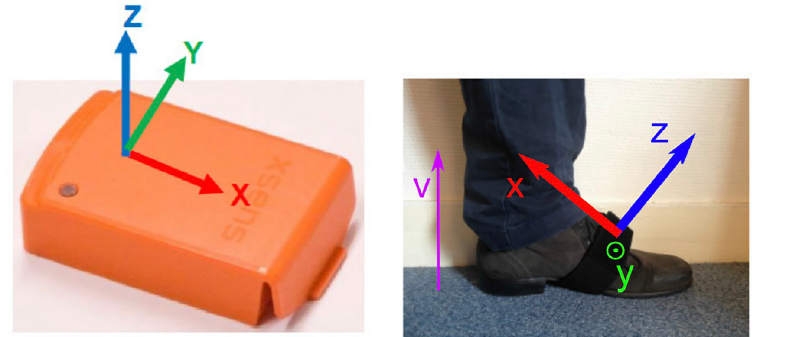
Fig 1. XSens sensor, with axes orientations. Source: [21].